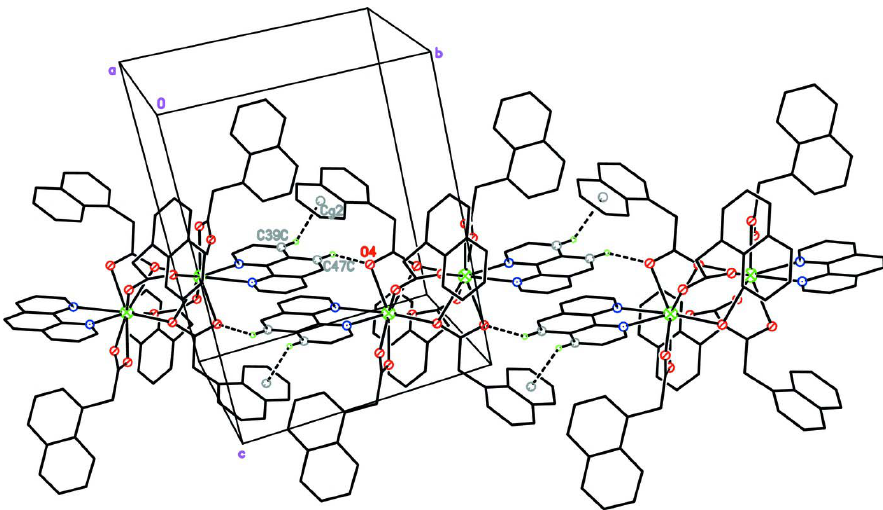
Figure 3 A larger portion of the crystal structure of (I), showing the formation of a hydrogen-bonded chain built from C—H··· π and C—H···O. For clarity, H atoms not involved in the hydrogen bonding have been omitted. Dashed lines indicate hydrogen bonds [symmetry codes: (C) 3 - x , 1 - y , 2 - z ].